Question: Briefly state, in one sentence, what is plotted here.
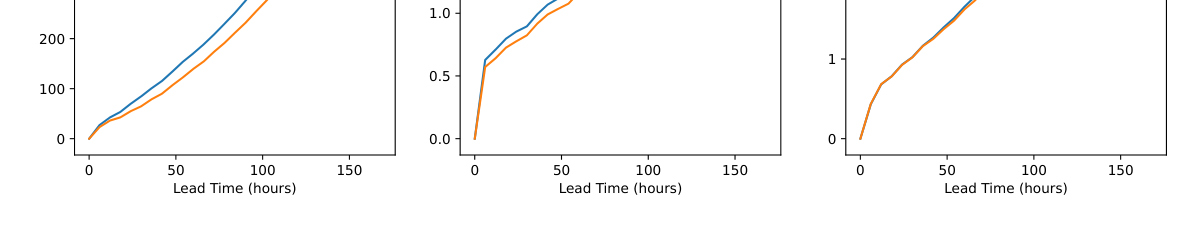
Answer: RMSE comparison of forecasts at lead times up to 7 days for the baseline depth 12 and embedding dimension 768 SwinV2 model with and without custom channel-weighting